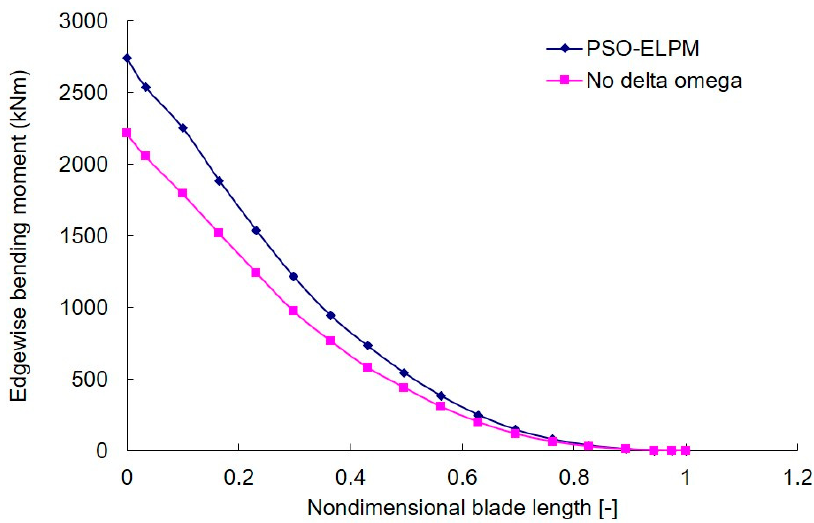
19 Figure 14. Comparison of extreme flapwise bending moment along the blade (1.5 MW). From Figures 14 and 16, we can see the flapwise bending moments are still very close. It means 